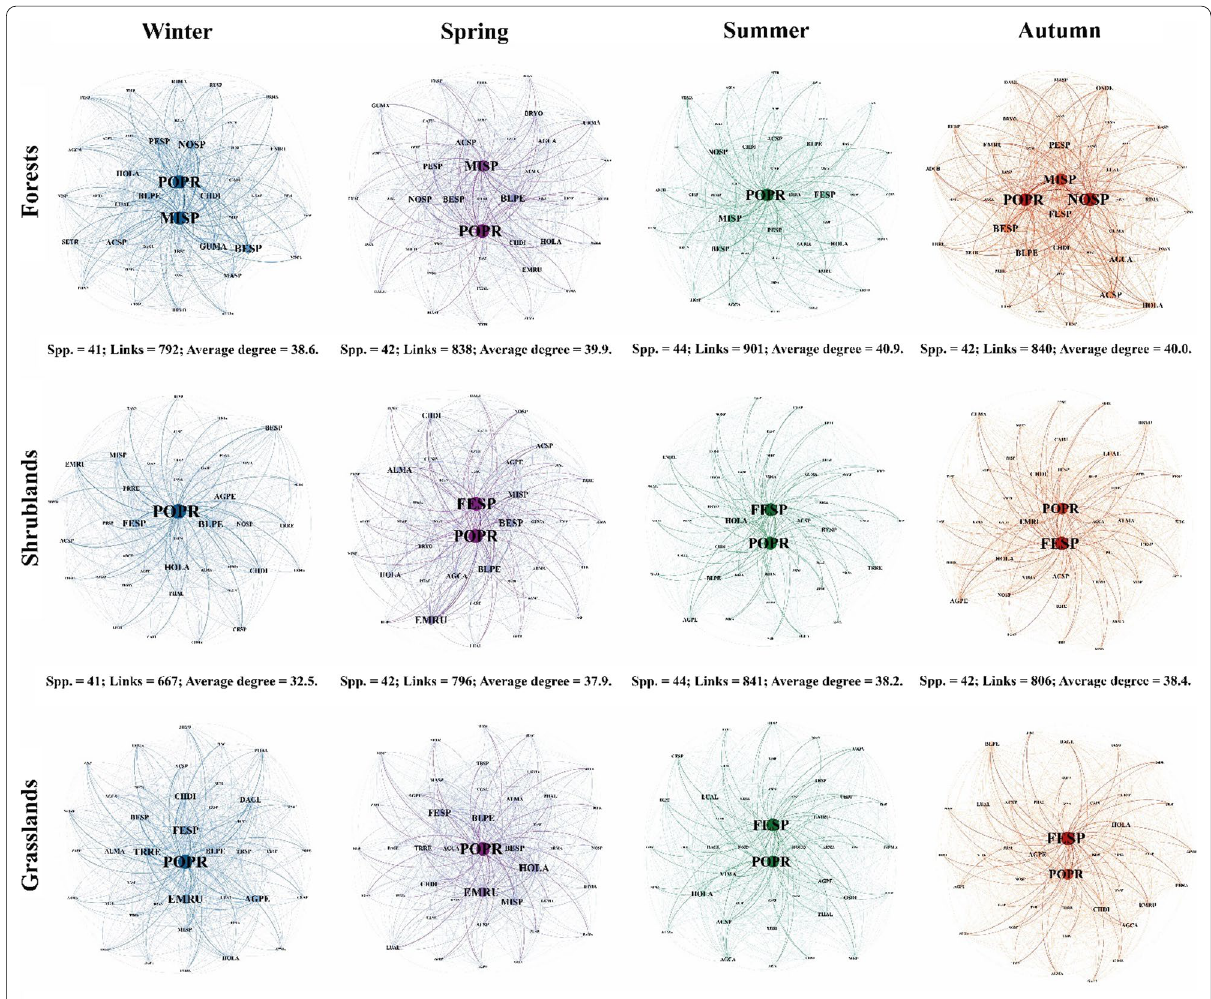
Fig. 4 Rabbit’s forage intake networks in the studied vegetation types for each season. The circles indicate the species (sp.) observed in the pellets, and the lines indicate the intake links between the species. The average degree indicates networks connected to a species with many or few links. The larger the letters of the name of each circle and the lines of the links, the more important the species are in the